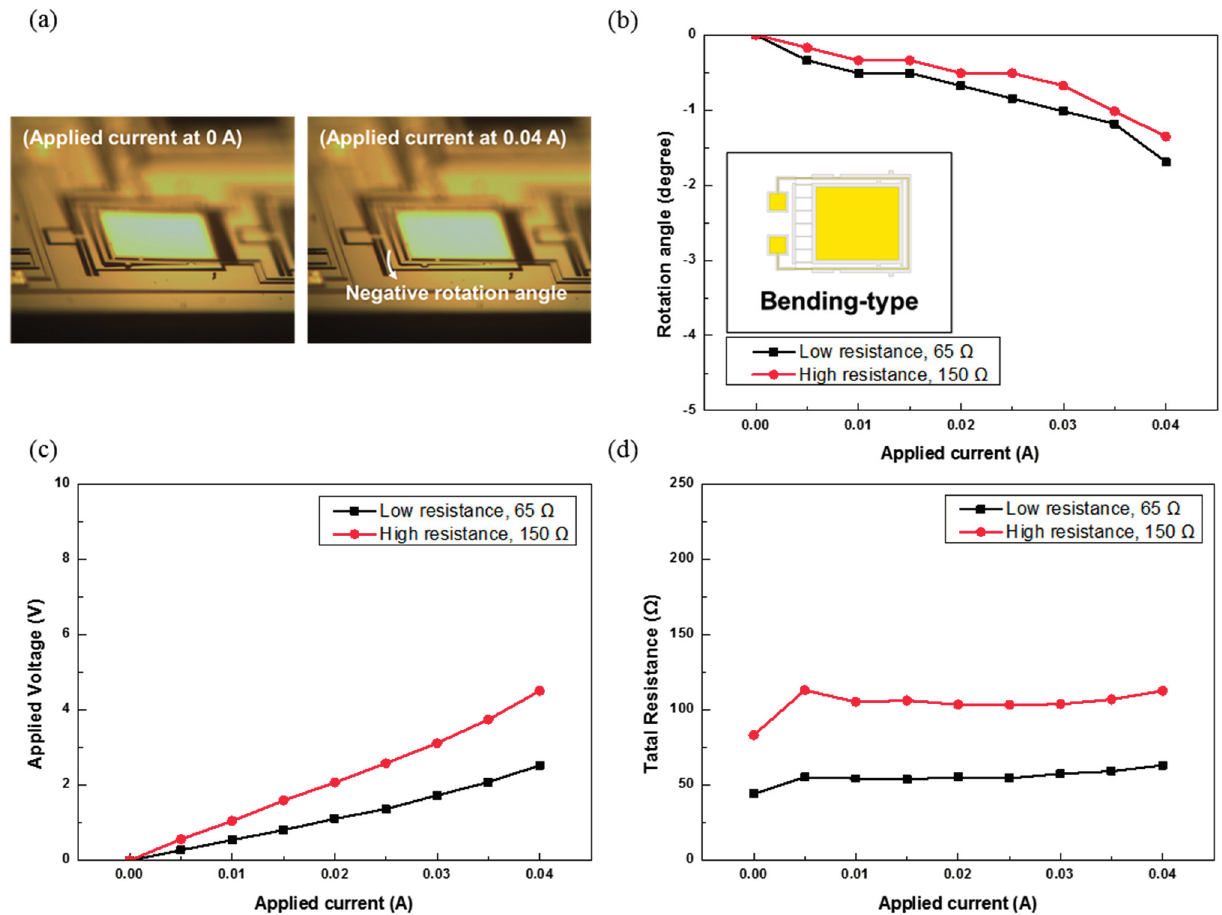
Figure 5. Experimental results for the bending-type MEMS mirrors of different wire resistances: ( a ) optical microscope images; ( b ) rotation angles; ( c ) applied voltages; and ( d ) total